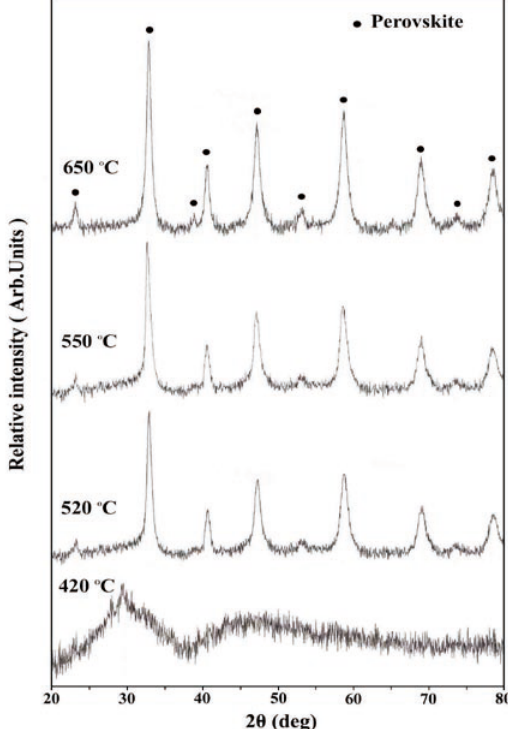
Figure 4. XRD of La